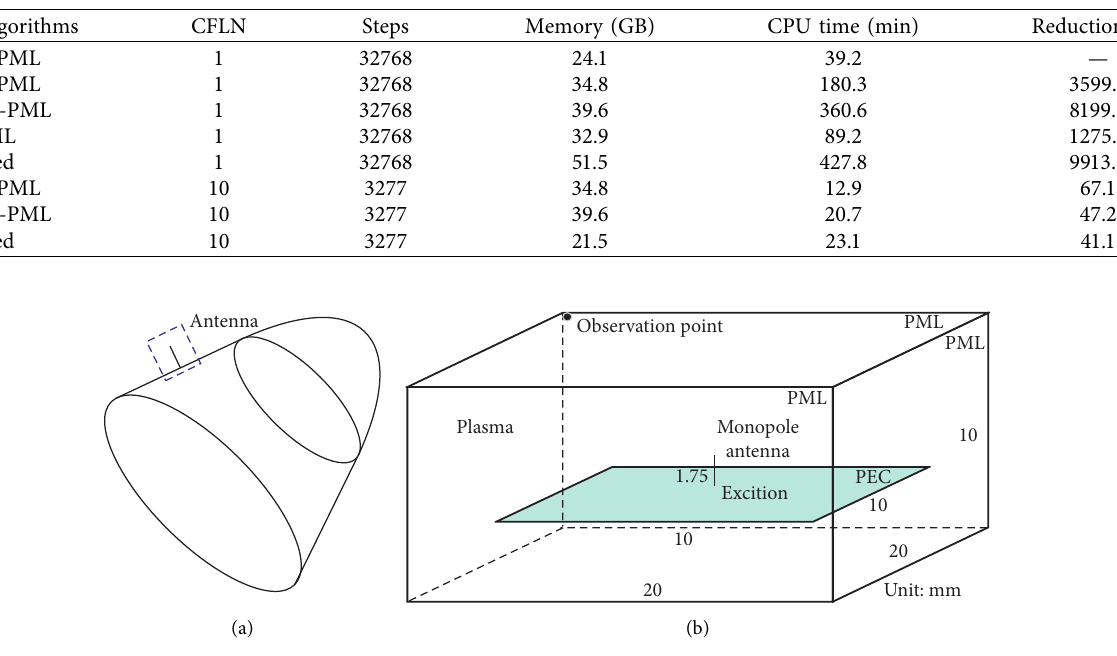
Figure 6: The antenna location and the sketch picture of the computational domain: (a) the monopole antenna on the surface of the flight; (b) the computational